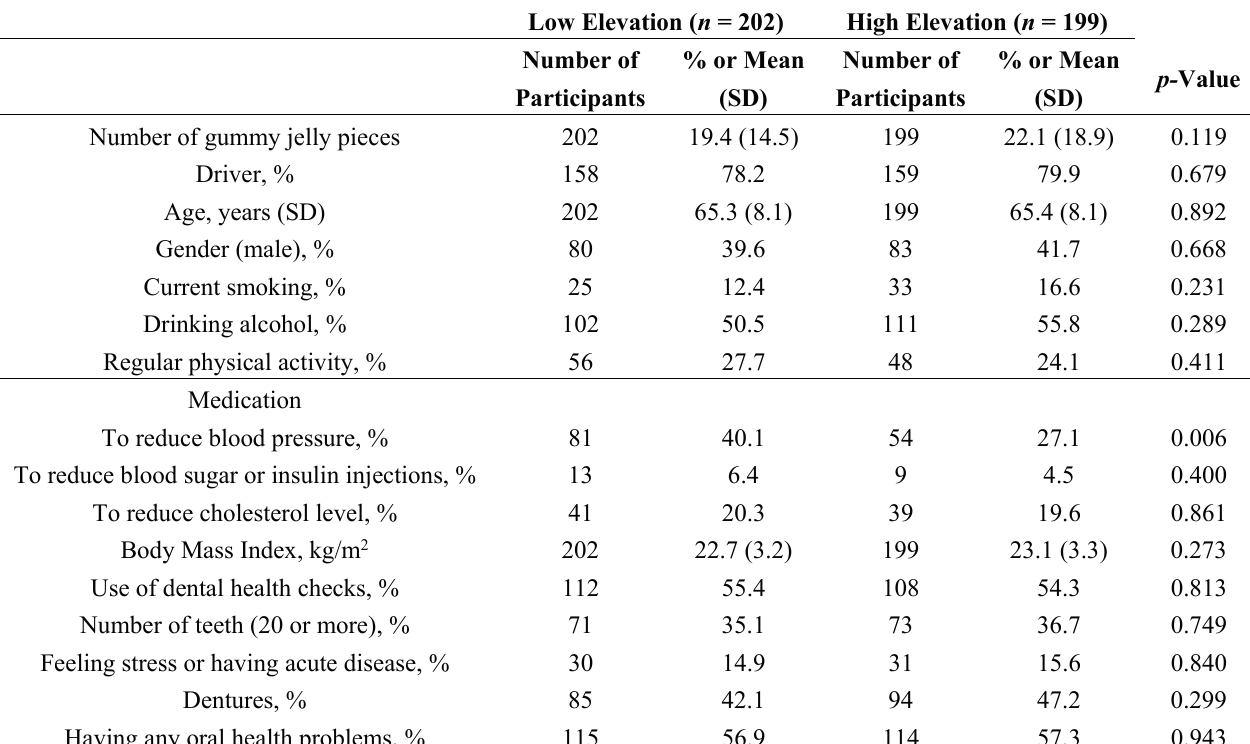
Table 2. Characteristics of the study participants in Iwami